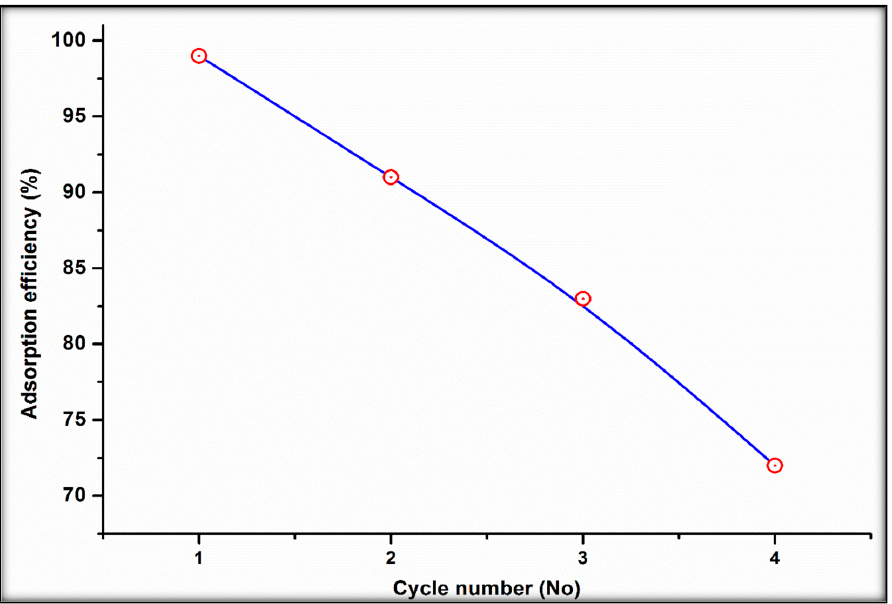
Figure 8. Reusability of BT-An@Zetag adsorbent composite.